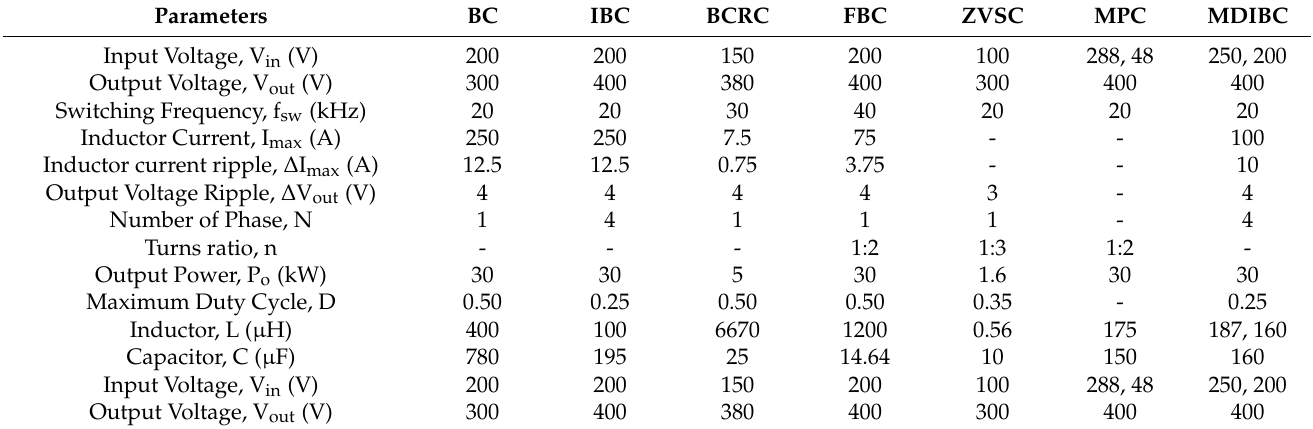
Table 4. Description Parameter Values of DC–DC Converters for MATLAB Simulation